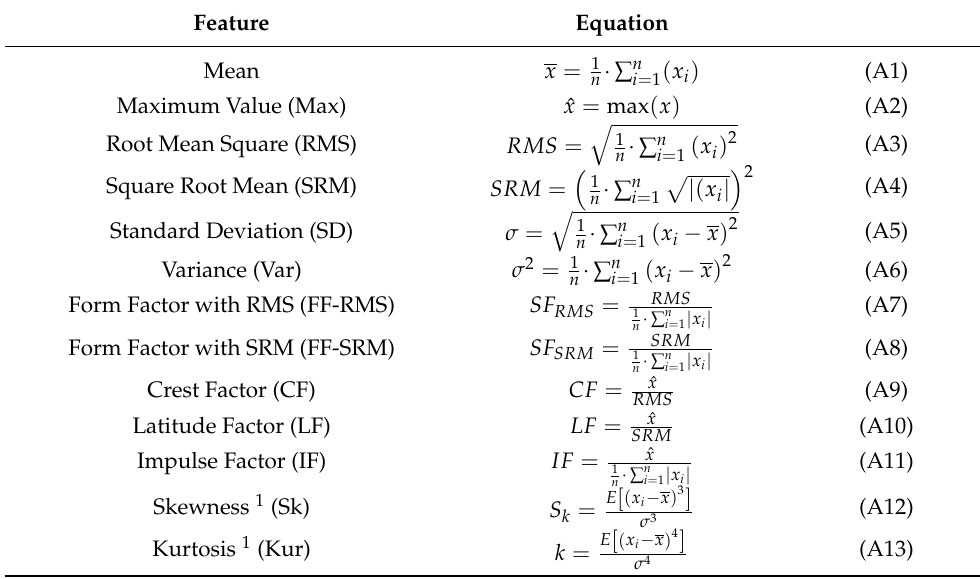
Table A1. Time-domain statistical features